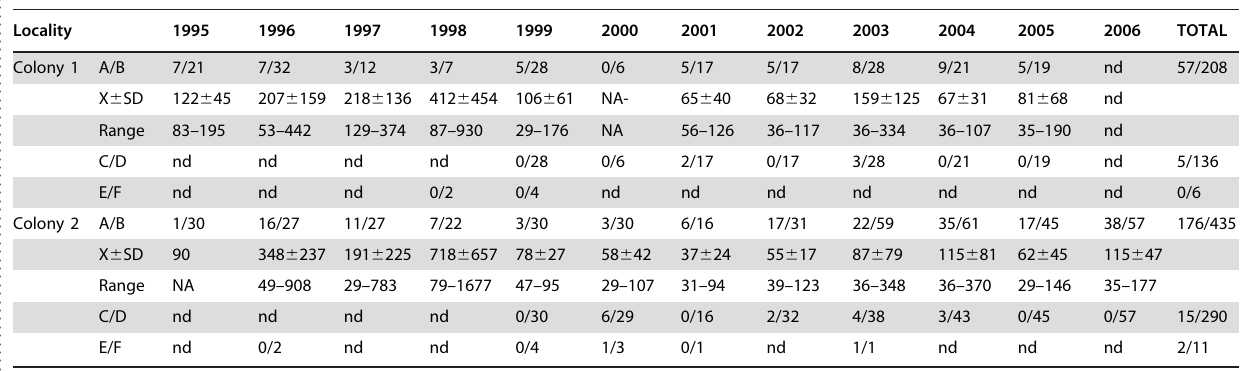
Table 1. Results from serologic and antigenic analyses in M. myotis. .. ... .... ... ... .... ... ... .... ... ... .... ... ... .... ... ... .... ... ... .... ... ... .... ... ... .... ... ... .... ... ... .... ... ... .... ... ... .... ... ... .... ... ... .